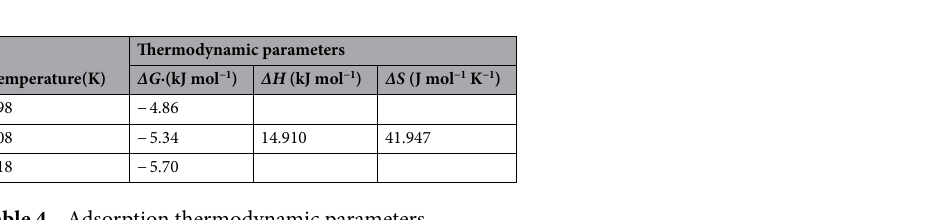
Table 4. Adsorption thermodynamic